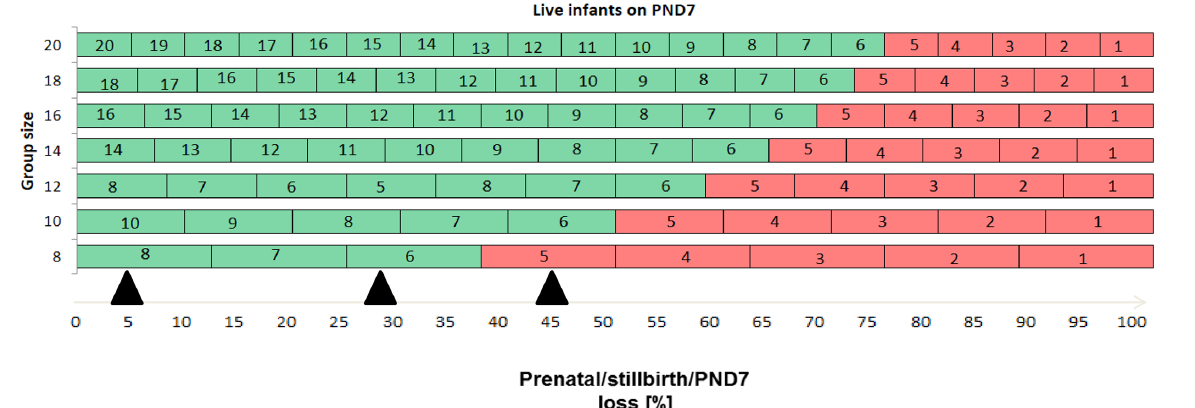
Figure 2. Relationship between group sizes within/above (green) or below (red) the recommended range of live infants on PND 7, pregnancy losses, and initial group size in ePPND studies. Triangles denote the observed minimal loss (5%), maximal loss (45%), and average/median loss (approx. 28%) as described in text and depicted in Fig. 1. As per ICH S6(R1) (2011), it is recommended to start with group sizes of pregnant animals that yield six to eight live infants per study group on PND7. Group sizes of 12–14 animals will achieve that recommendation.